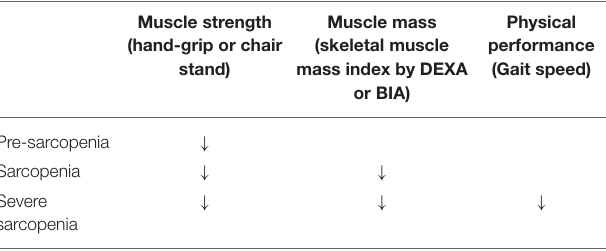
TABLE 2 | Criteria for sarcopenia by the European Working Group for Sarcopenia (EWGSOP2) (88). Muscle strength (hand-grip or chair